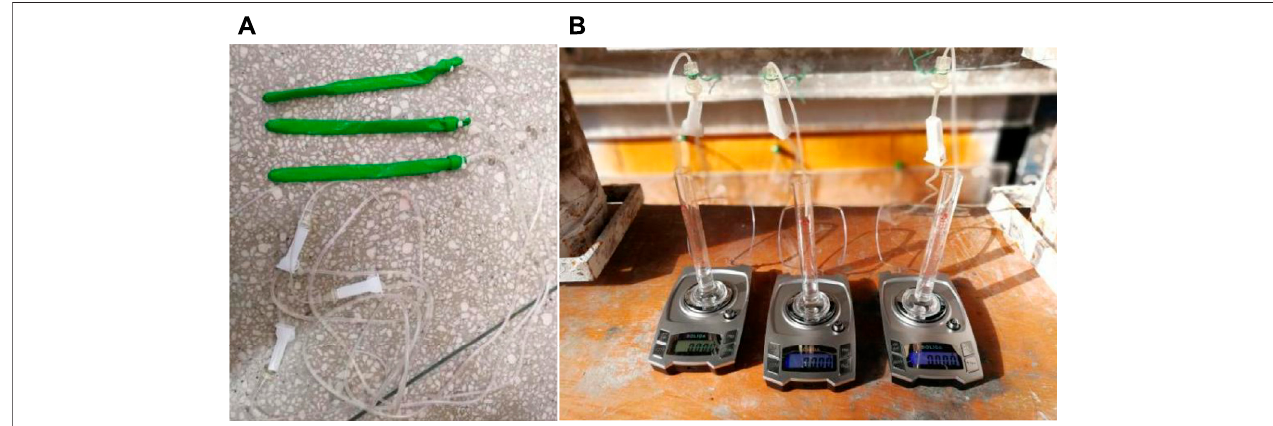
FIGURE 4 | Borehole deformation measuring device. (A) pouch, (B) electronic scale.